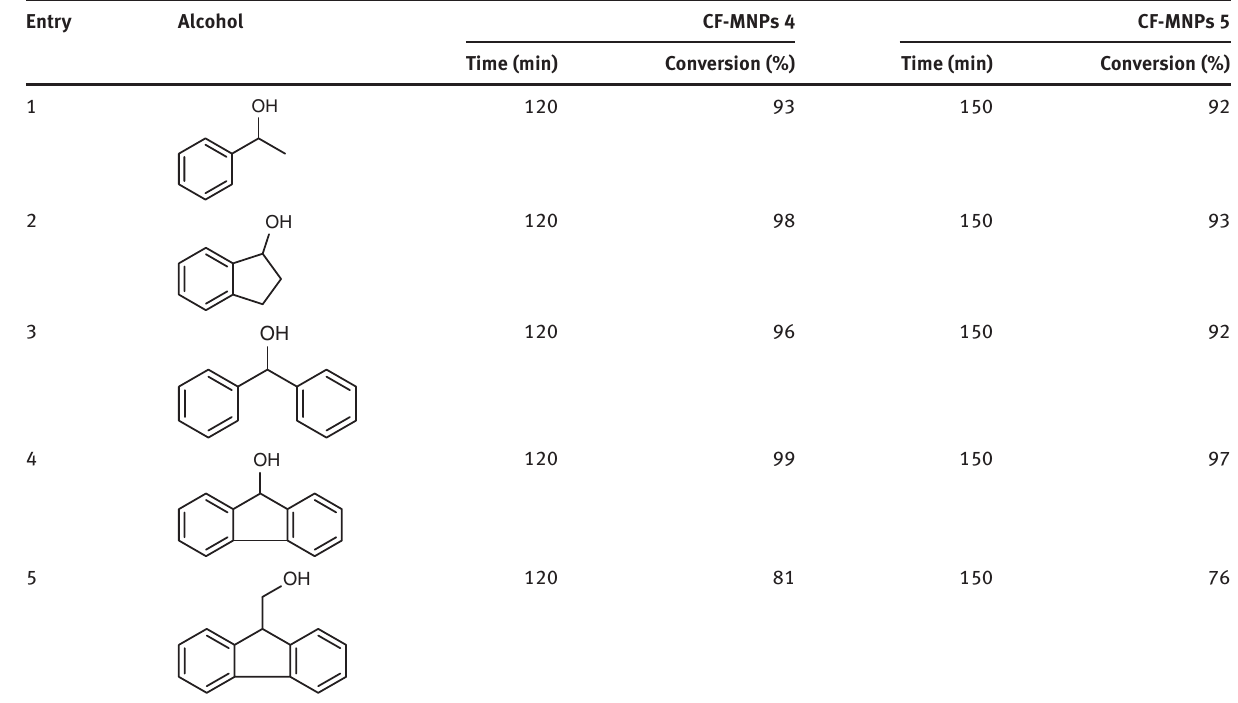
Table 1: CF-MNPs 4 and CF-MNPs 5 catalyzed the oxidation of alcohols to the carbonyl